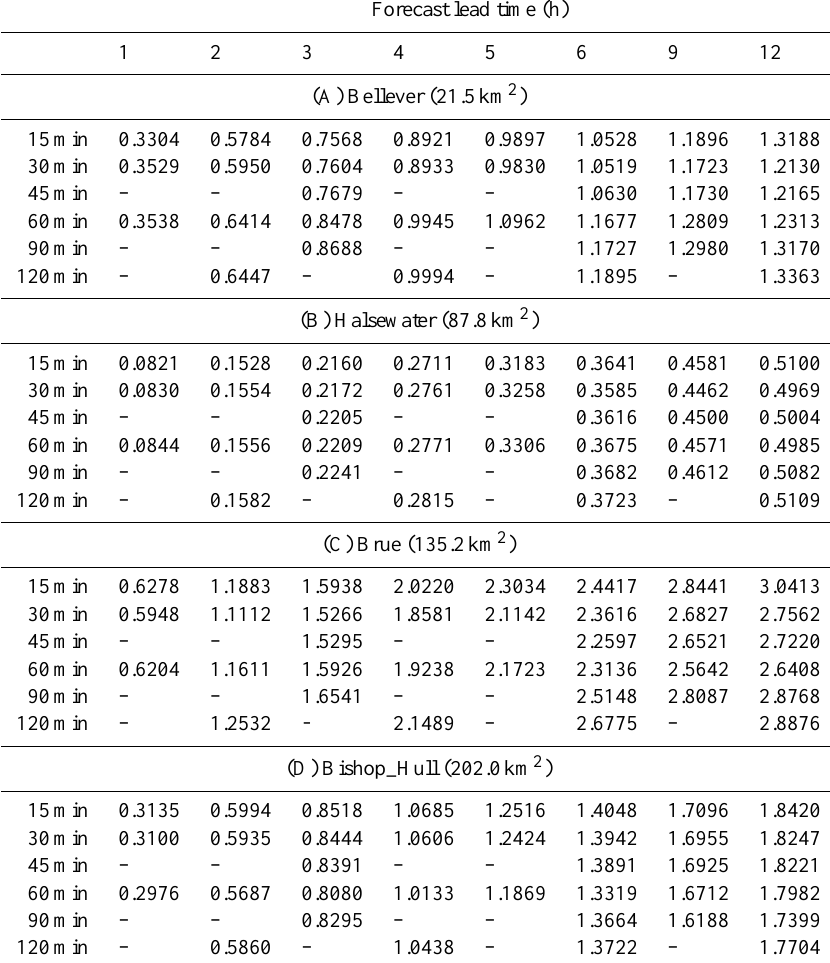
Table 9. Forecasting results shown in RMSE (m 3 s − 1 ) for the four catchments using data with different time intervals: similar to Table 7 but without updating of the ARMA model. The lowest RMSE value for a certain lead time is highlighted to show the optimal data time